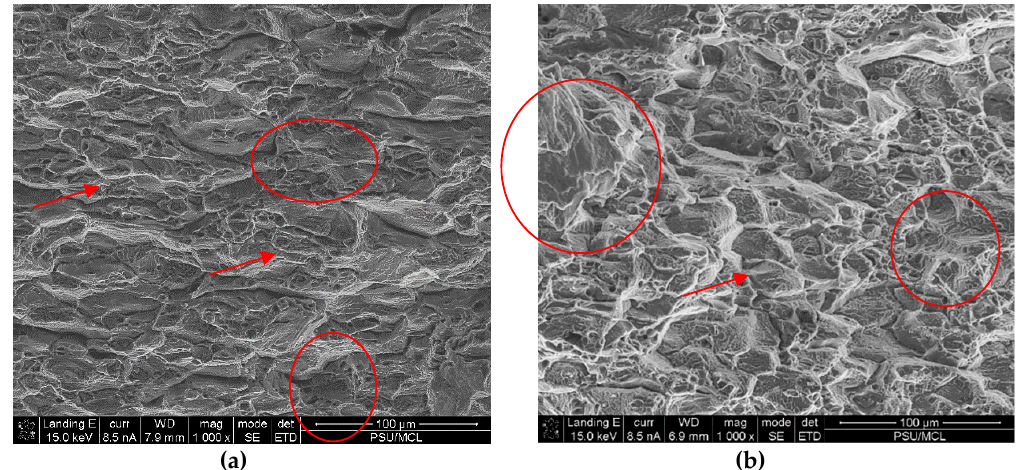
Figure 17. Secondary electron images of wrought Al 6061-T6 fracture surfaces. The fractography predominately shows cleavage and transgranular fracture (circles), but intergranular facture is also present (arrows) in ( a ) 65% and ( b ) 85% stress